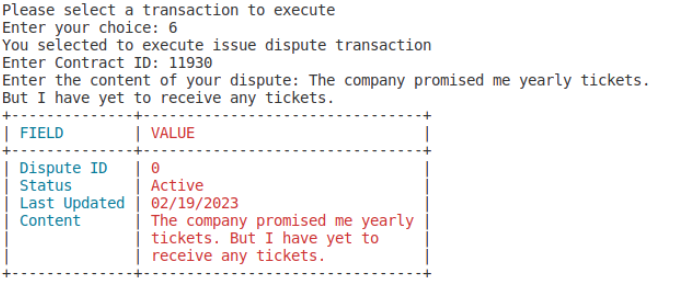
Figure 9. An employee peer issues the “IssueDispute” transaction to raise a complaint related to the employment contract.